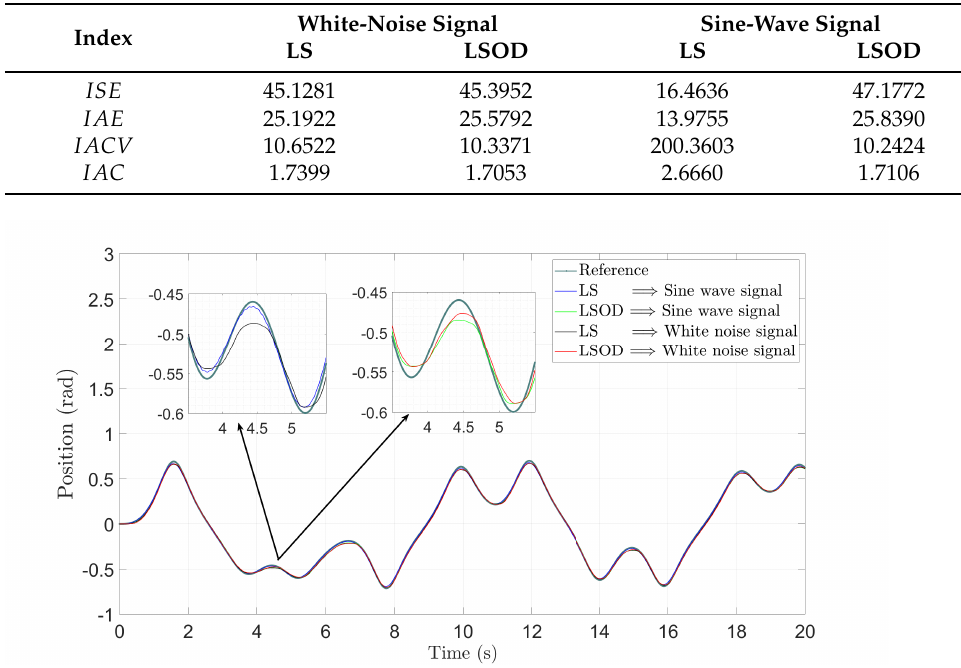
Figure 11. Reference and servo system angular positions produced by control law (62) with the parameter estimate β ∗ . 0